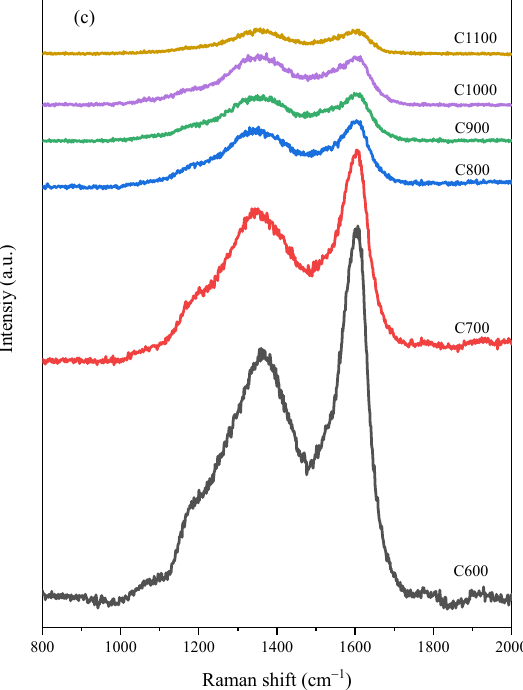
Figure 1. Typical Raman spectra of chars prepared at different temperatures: ( a ) coal char A; ( b ) coal char B; ( c ) coal char C.